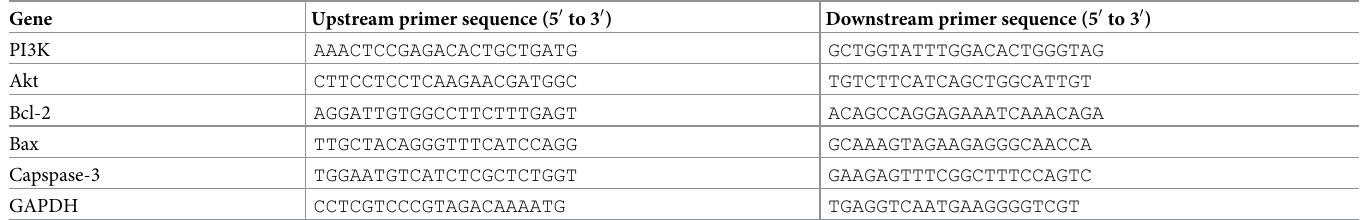
Table 1. Primer sequences used for